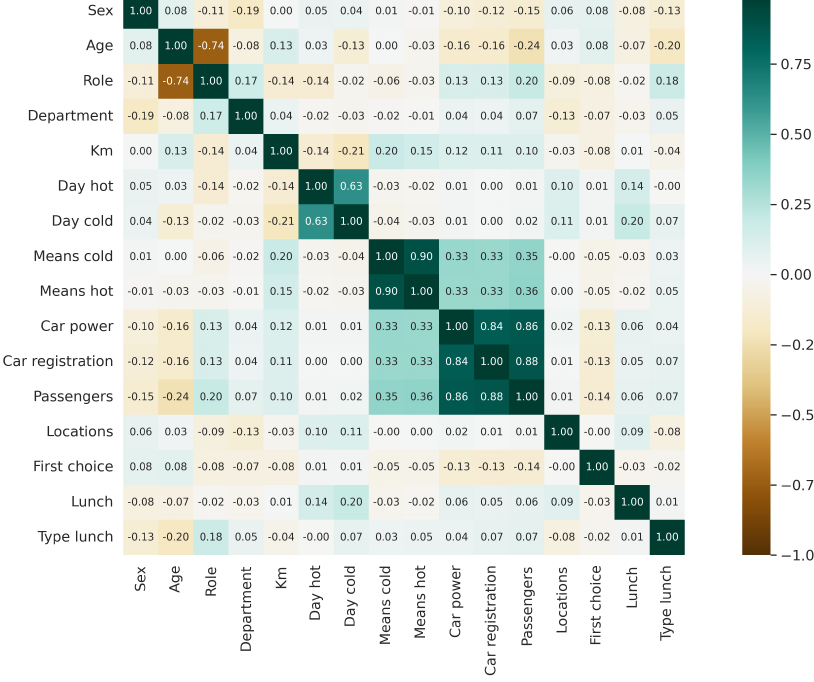
Figure 1. Heat map of correlations. Table 2. Significance values ( p -values) of the correlation values (lower the